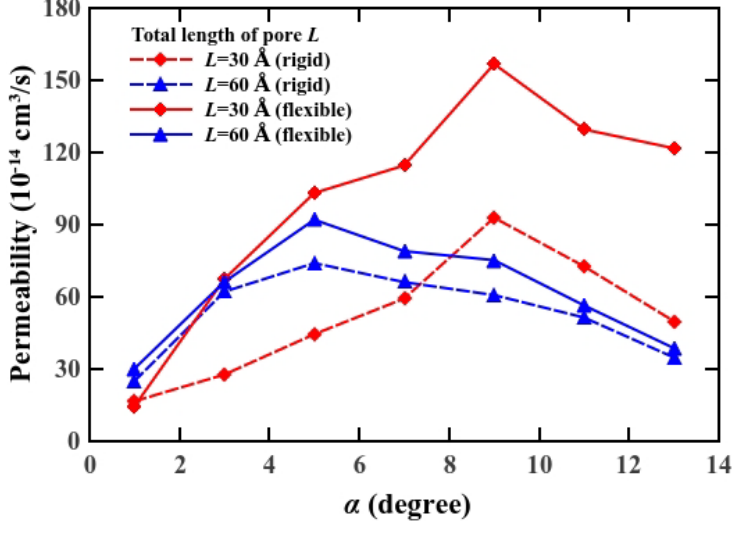
Figure 4. Osmotic permeability of water through the pores versus the cone angle α .